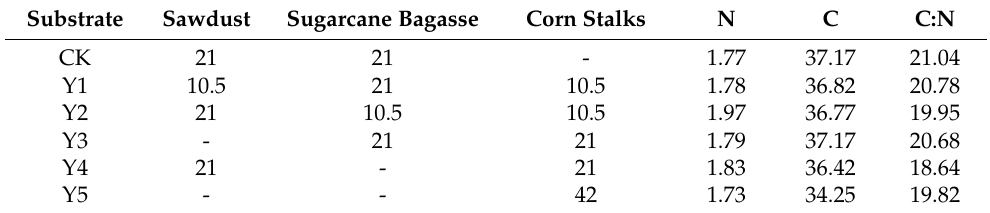
Table 1. Composition of ingredients for the substrates with different inclusion rates for Pleurotus eryngii cultivation * (g 100 g − 1 except for the